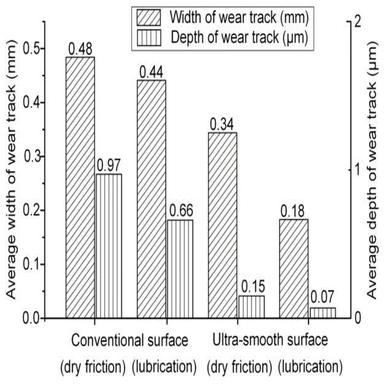
Measured average dimension of the generated wear tracks under different surface status and lubrication conditions.